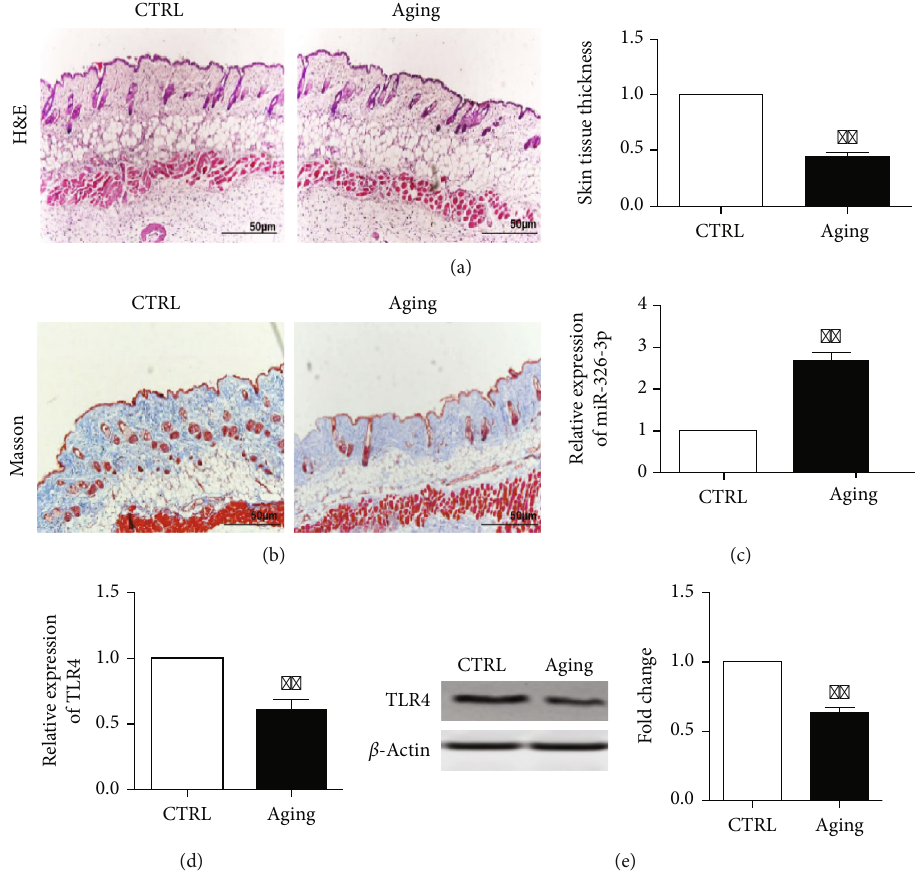
Figure 6: miR-326-3p and TLR4 expression in aging skin tissue. (a) HE staining and dermal thickness analyze of aging mice skin tissue (10 × ). (b) MASSON staining of aging mice skin tissue (10 × ). (c) The miR-326-3p expression in aging skin tissue. (d) The TLR4 mRNA expression in aging skin tissue. (e) The expression of TLR4 protein in aging skin tissue. ∗∗ p < 0 : 01 vs. CTRL group. CTRL: